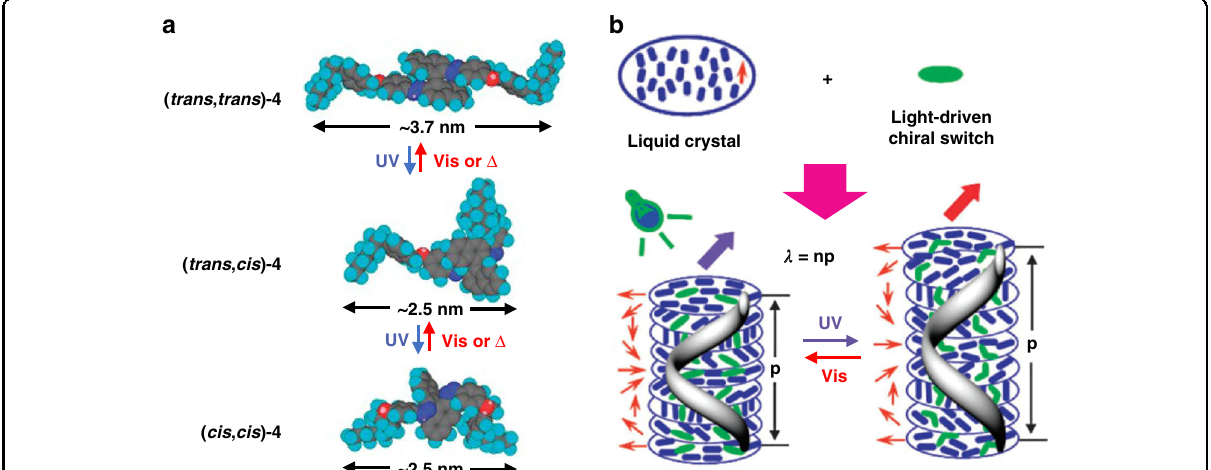
Fig. 14 Light-driven switchable optical devices. a Photo-driven cis-trans isomerization process of chiral molecular switches. b Schematic diagram of the mechanism by which light is reversibly and dynamically tuned to the re fl ected wavelength. a, b Reproduced with permission from ref. 170